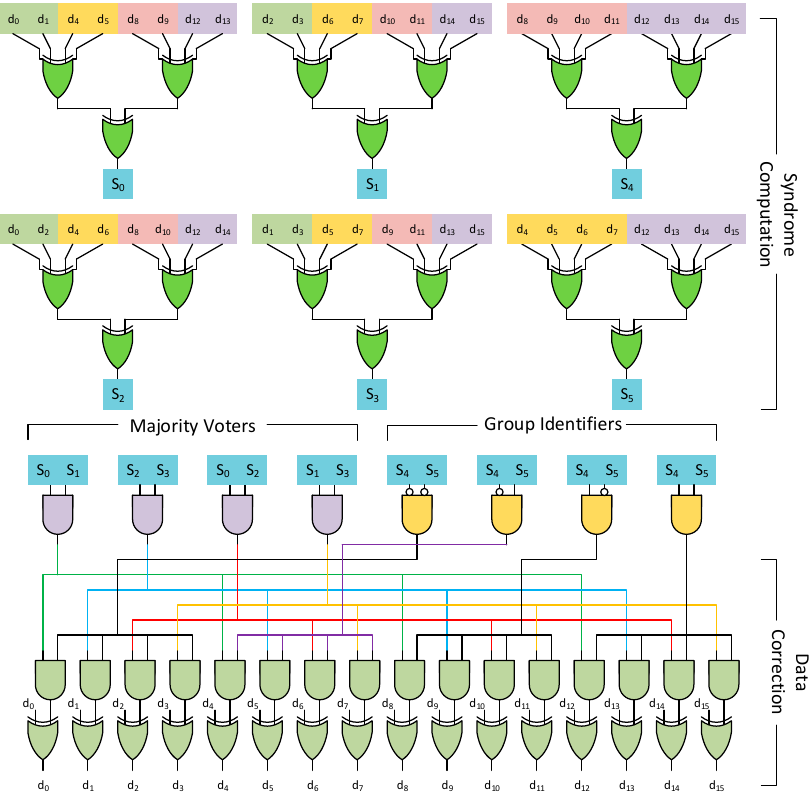
Figure 7. Decoding circuit of the proposed codes for four groups with four data bits